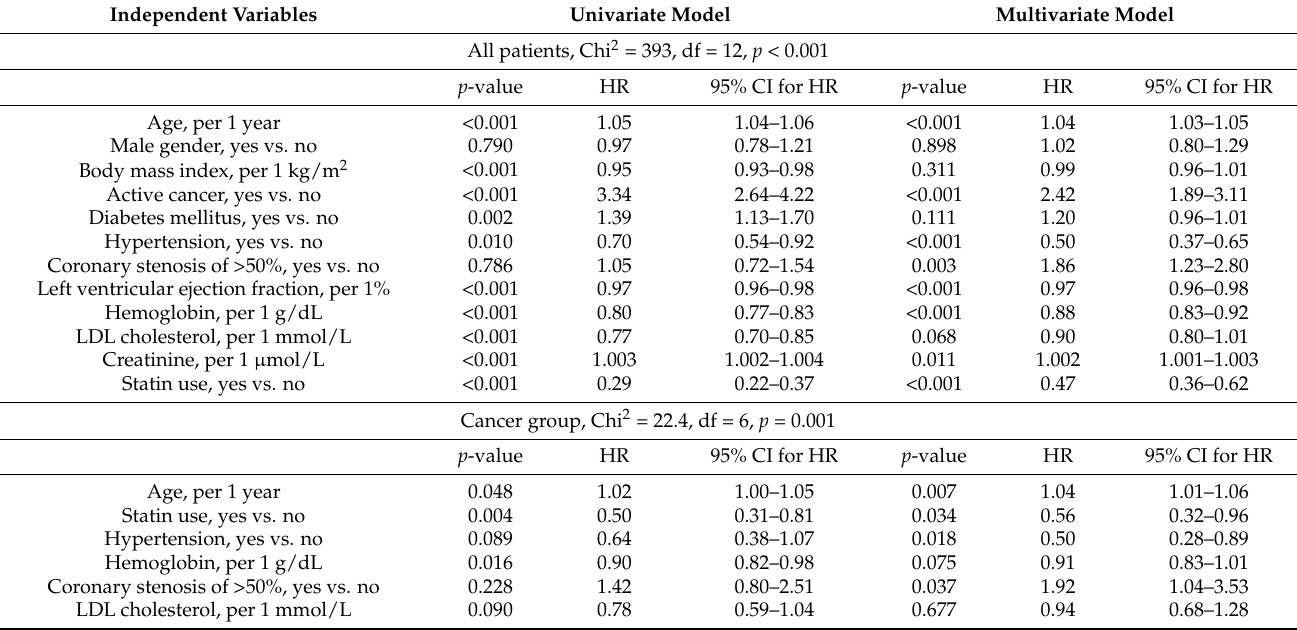
Table 4. The Cox proportional hazard regression of all-cause long-term mortality. Independent Variables Univariate Model Multivariate